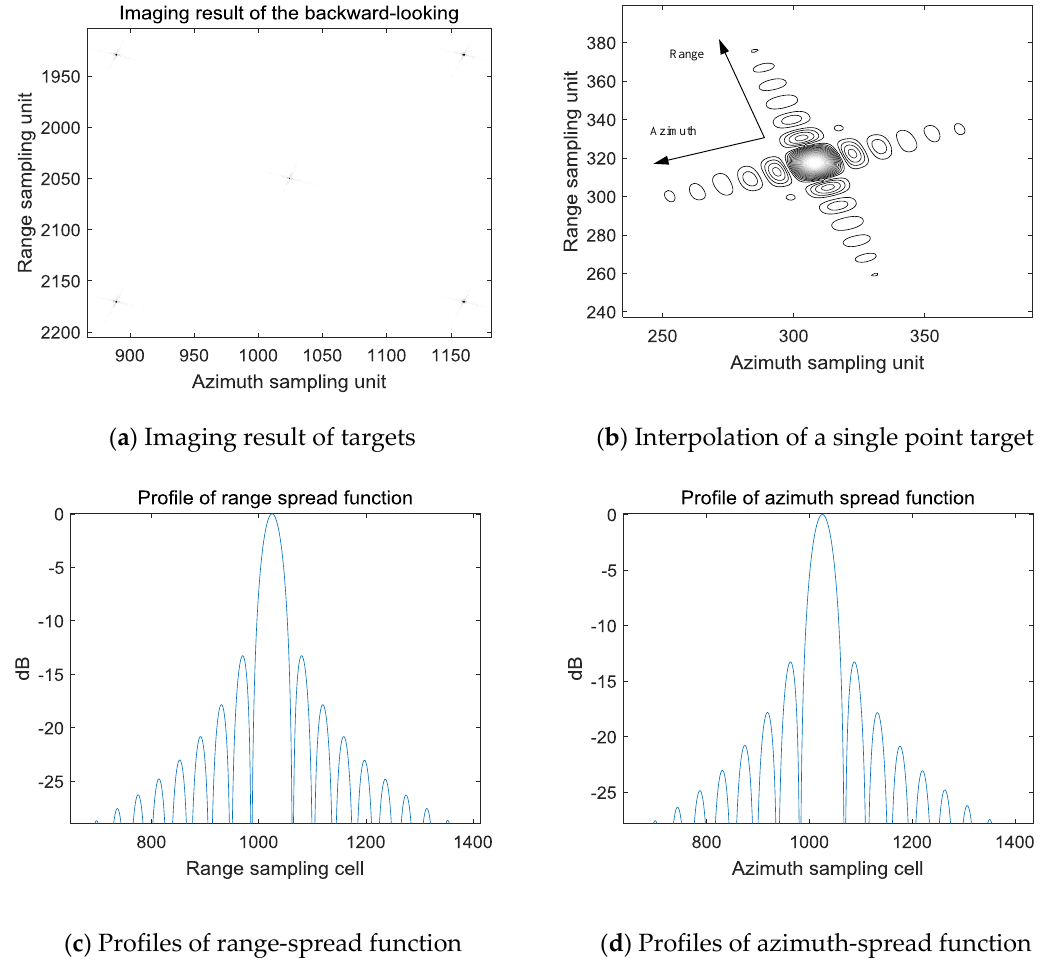
Figure 13. Imaging result of the backward-looking beam.